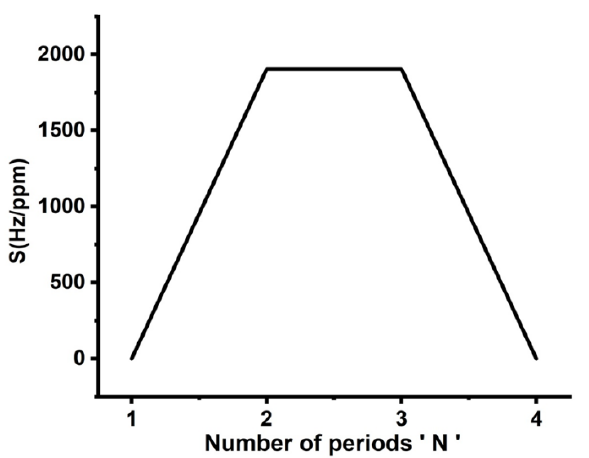
Figure 7. Dependence of the proposed sensor’s sensitivity on the number of periods of 1D -PnC.